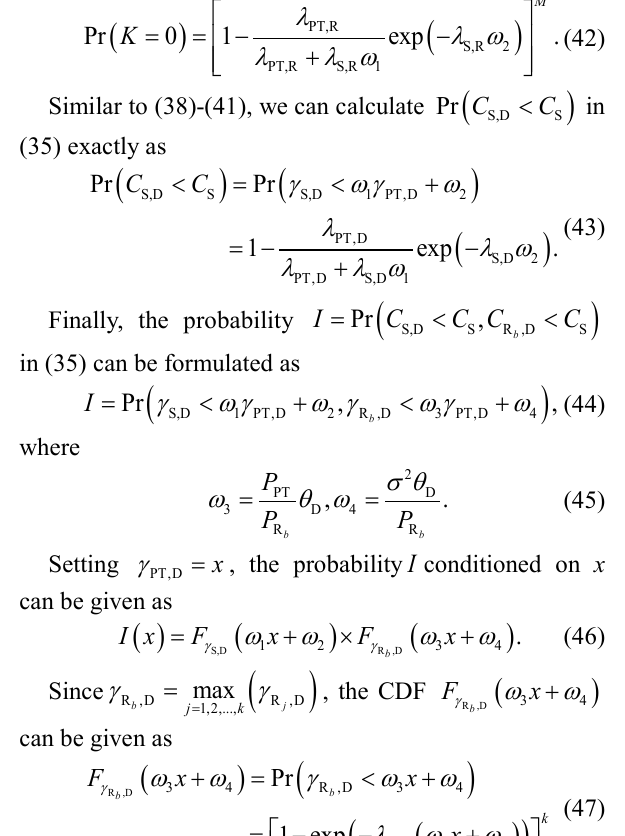
P as a function of P and S R